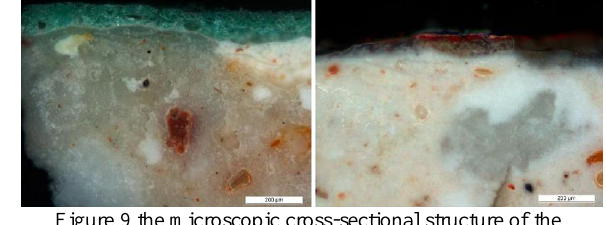
Figure 13 hyper-spectral shooting result of light green